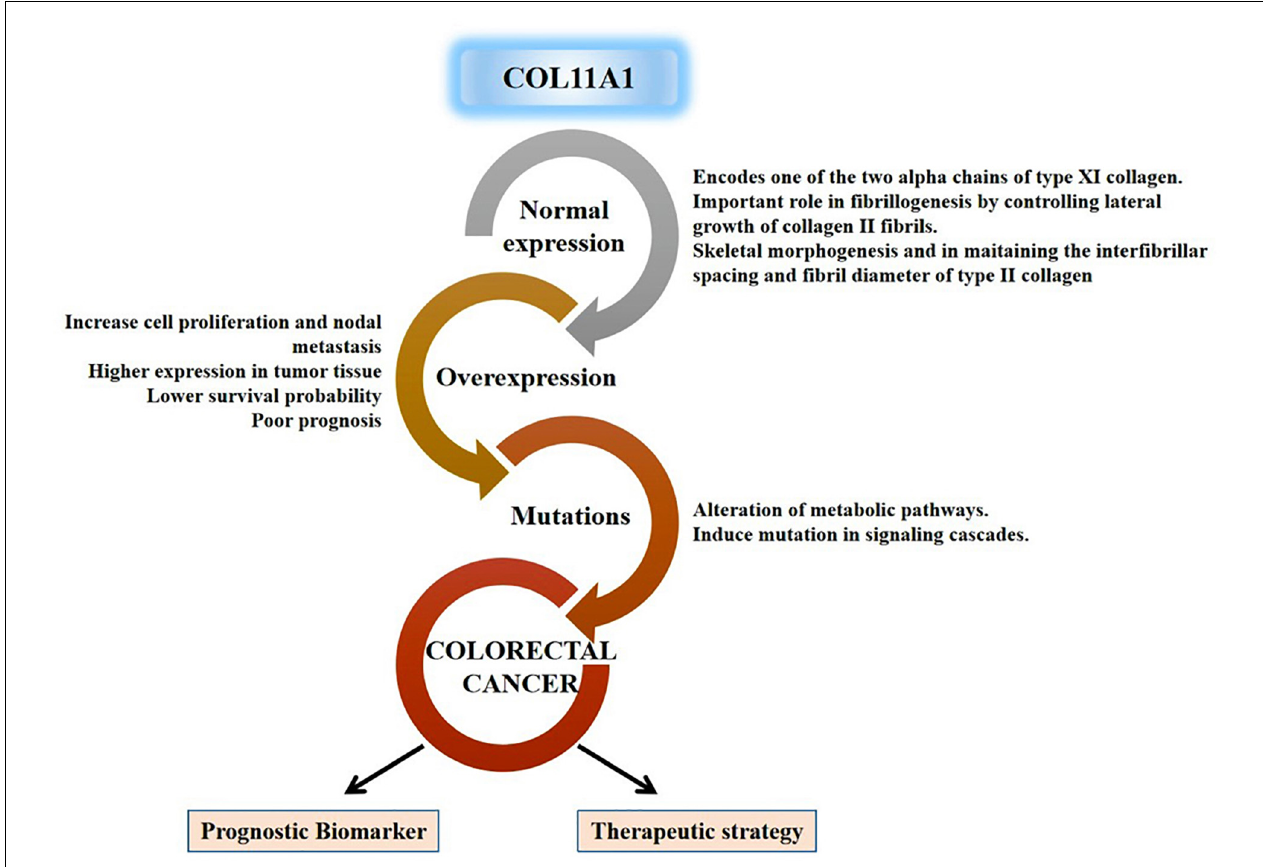
FIGURE 8 | Schematic representation for functional relevance of COL11A1 gene in the oncogenesis of colorectal cancer and its candidature as a prognostic biomarker and therapeutic target.